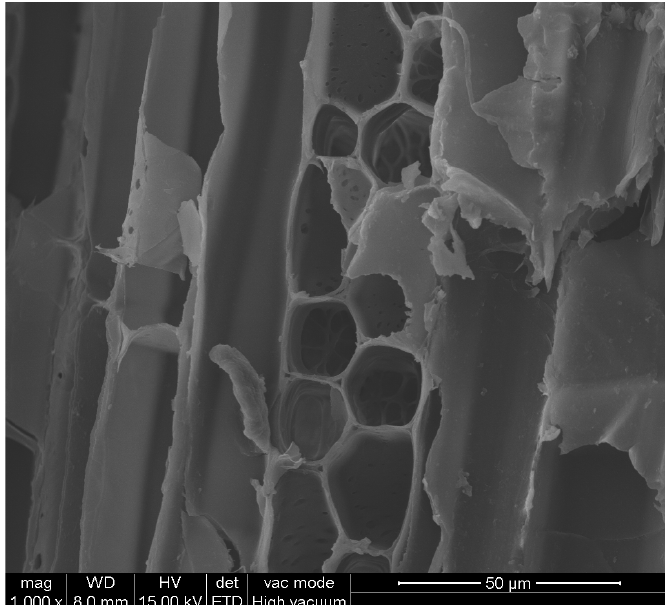
Figure 8. Untreated Ayous.